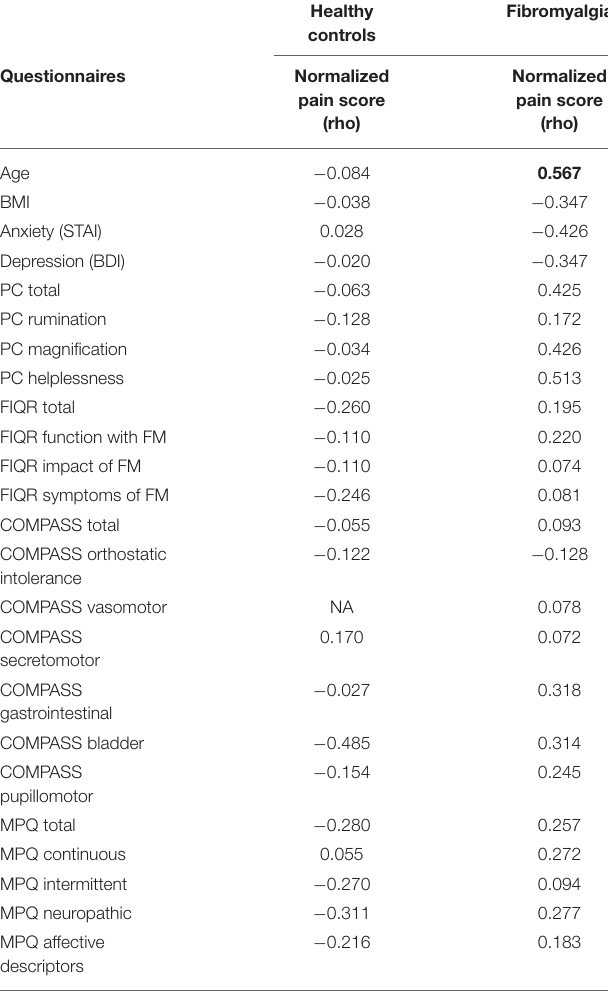
TABLE 4 | Summary of significant spinal cord/brainstem connectivity in the healthy control (first column) and fibromyalgia (second column) groups, analyzed with SEM. The upper section of the table summarizes connectivity during the Expectation period, and the lower section summarizes the Stimulation